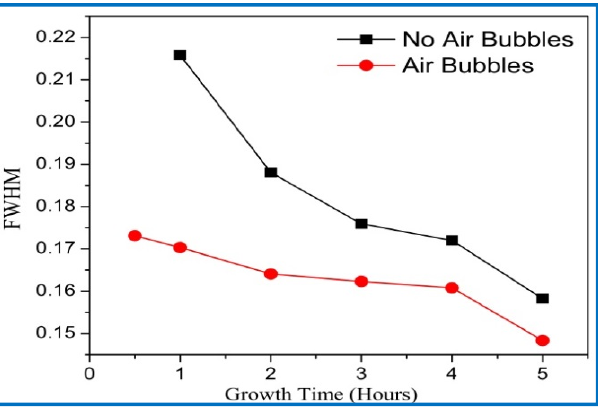
Figure 11. Full width at half maximum (FWHM) of ZnO nanorods of diffraction peak (002) with growth time for both cases: air bubbles not involved and air bubbles involved. growth time for both cases: air bubbles not involved and air bubbles